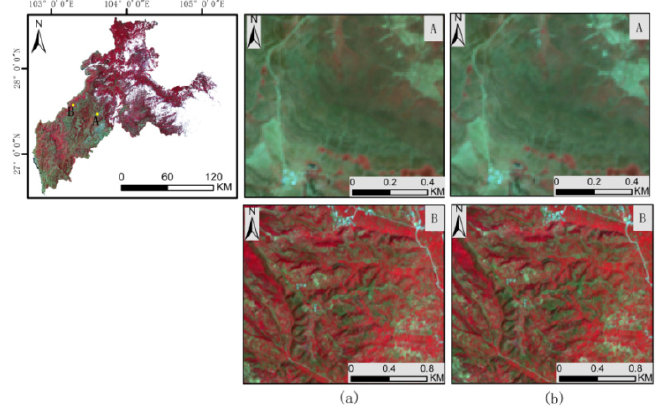
Figure 15. Synthetic image comparison: ( a ) Shows a column of direct mosaic images and ( b ) shows a column of time-consistent images. A is the junction of images from di ff erent sensors; B is the junction of images from the same sensor. images from the same